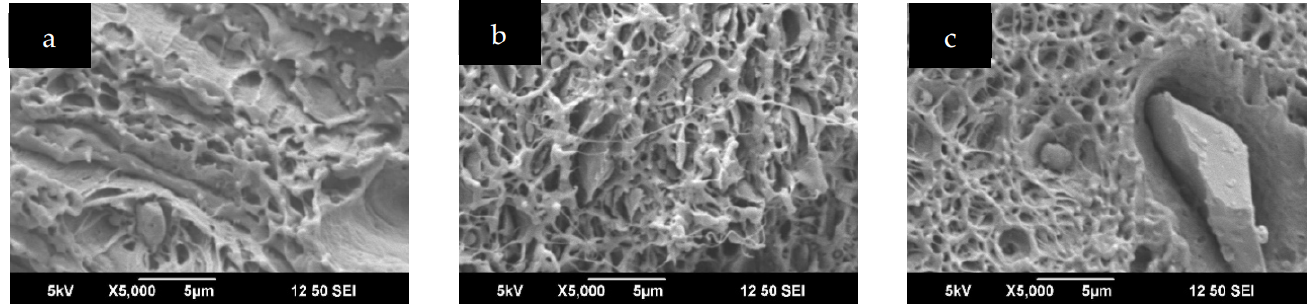
Figure 2. SEM images of selected ternary blends: ( a ) o-HDPE (30%) _o-PP (30%)_v-LDPE (30%), ( b ) o-HDPE (30%)_o-PP (30%)_v-LDPE 30%)_clay (10%), ( c ) o-HDPE (25%)_o-PP (25%)_v-LDPE (25%)_EPR (25%).